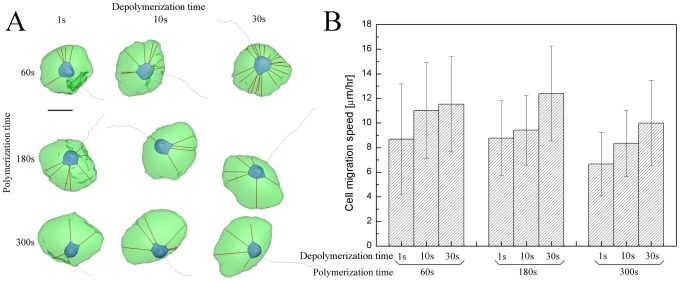
Optimal condition of cell migration.A) Trajectories and morphologies of simulated cell migrations along the planar surface of fibronectin surface density of 1140 molecules/µm2 for three hours under nine different cases of polymerization times with 60, 180, and 300 s (rows) and depolymerization times with 1, 10, and 30 s (columns), and B) bar graphs showing time-averaged cell migration speeds and error bars indicate standard deviations for nine different cases in A). Scale bar is 10 µm.